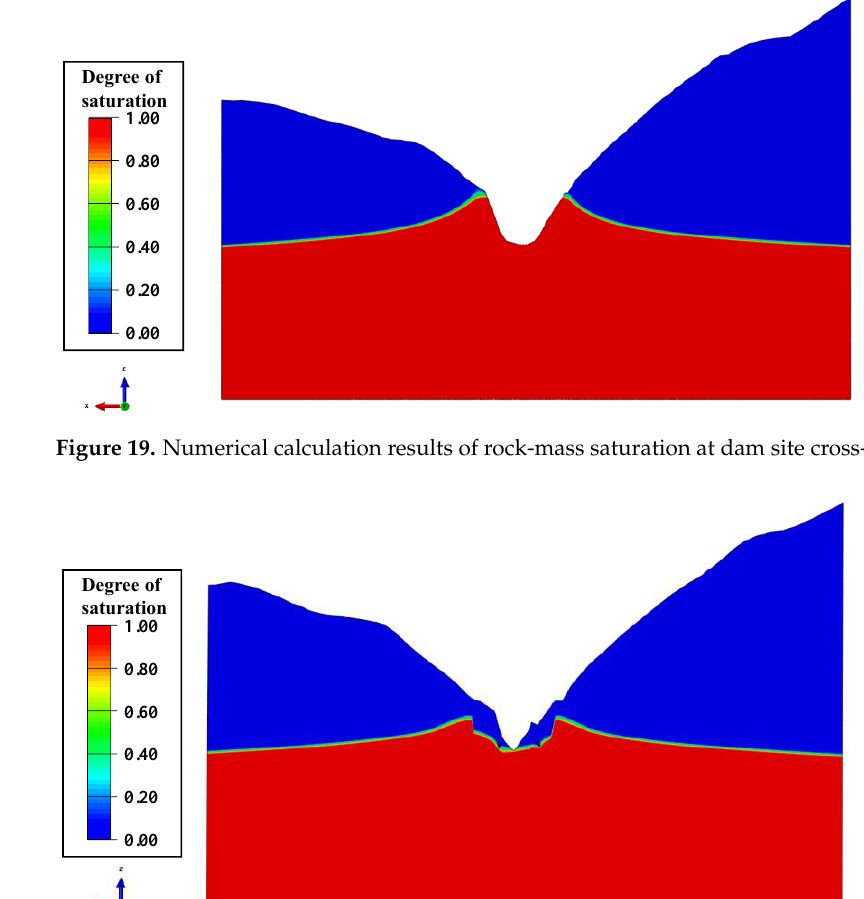
Figure 20. Numerical calculation results of rock-mass saturation at curtain section.